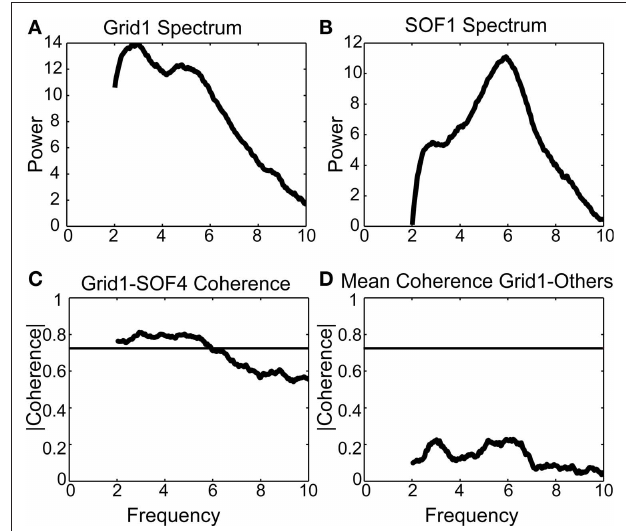
FIGurE 8 | Low-frequency coherence between channels identified by independent component 1 (IC1). (A) Multi-taper power spectral estimates intracranial channel Grid1. (B) Multi-taper power spectral estimate of intracranial superior orbital frontal channel SOF1 ( Figure 7A ). (C) The two channels, identified by IC3 in Figure 2 , are significantly coherent in the delta band, consistent with the clinical report describing “episodes of coincident rhythmic moderate amplitude delta frequency” on these electrodes. (D) By contrast, the coherence of Grid1 with each of its next-nearest neighboring channel is not statistically significant; the average of these five coherences is shown